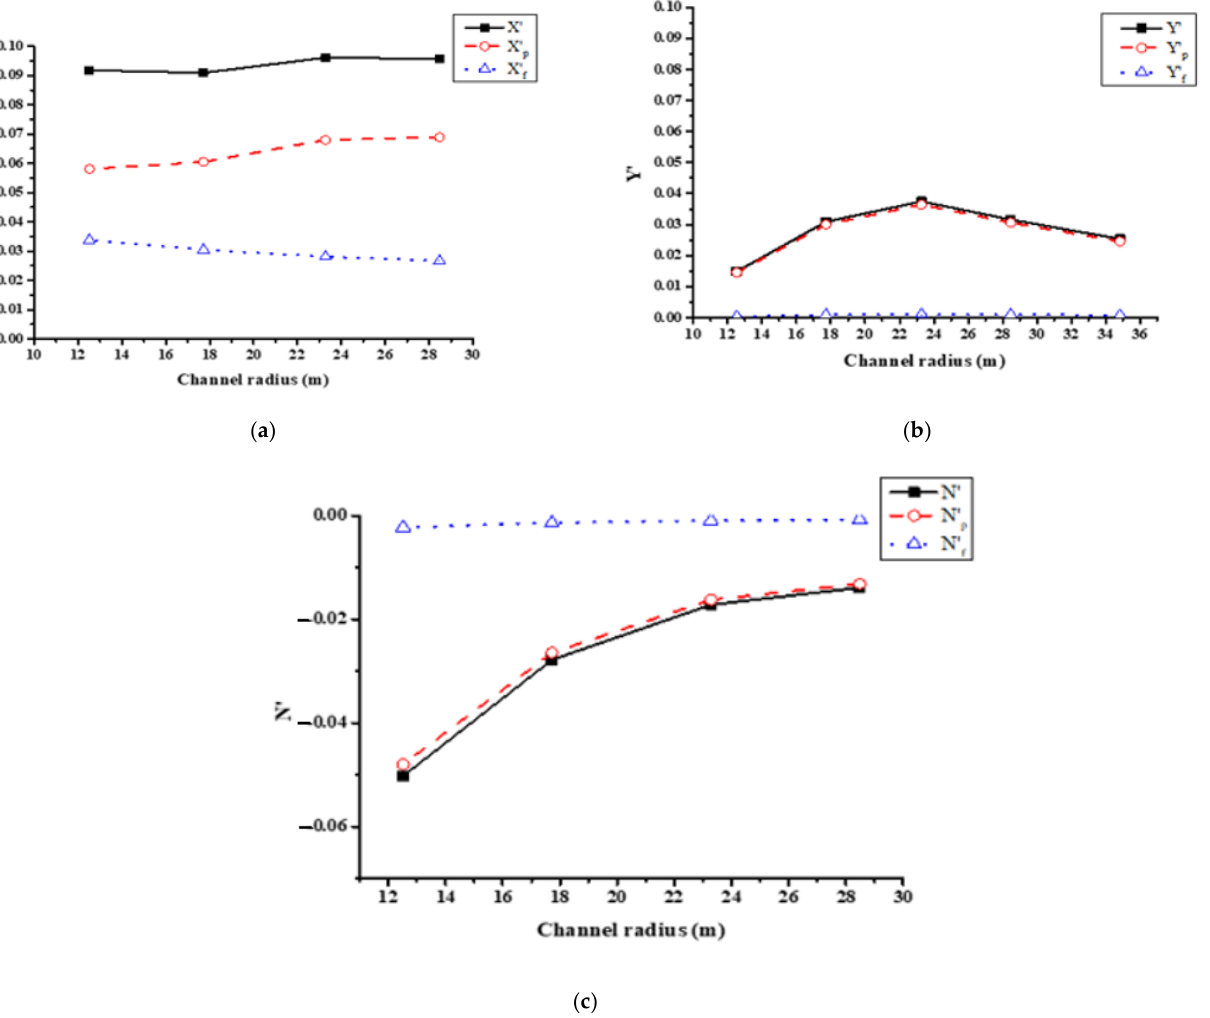
Figure 8. Non–dimensional results of channel radius on ship hydrodynamics. ( a – c ): resistance force, sway force, yaw moment